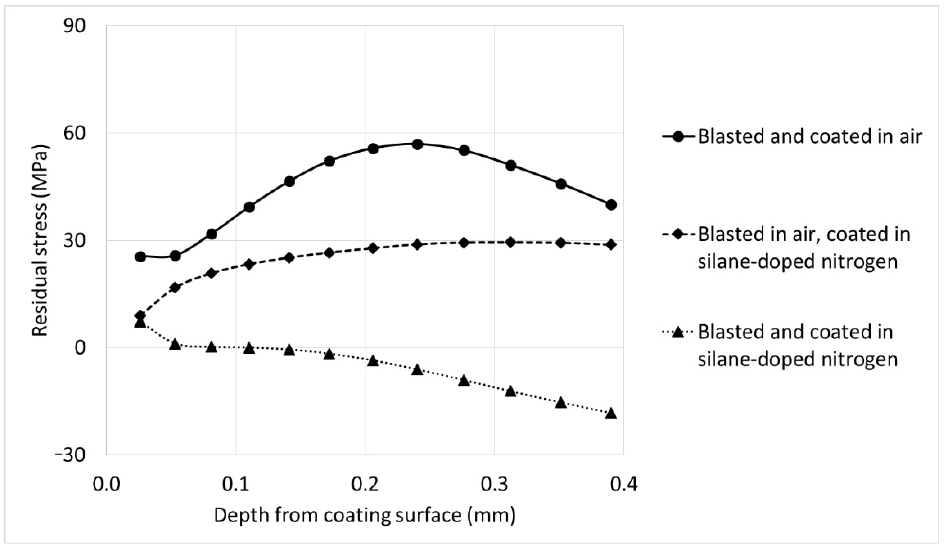
Figure 11. Residual stress within wire arc sprayed copper coatings.